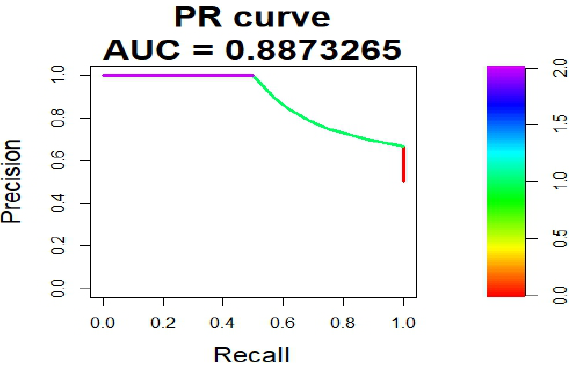
Figure 7. Area under PR curve for Naive Bayes